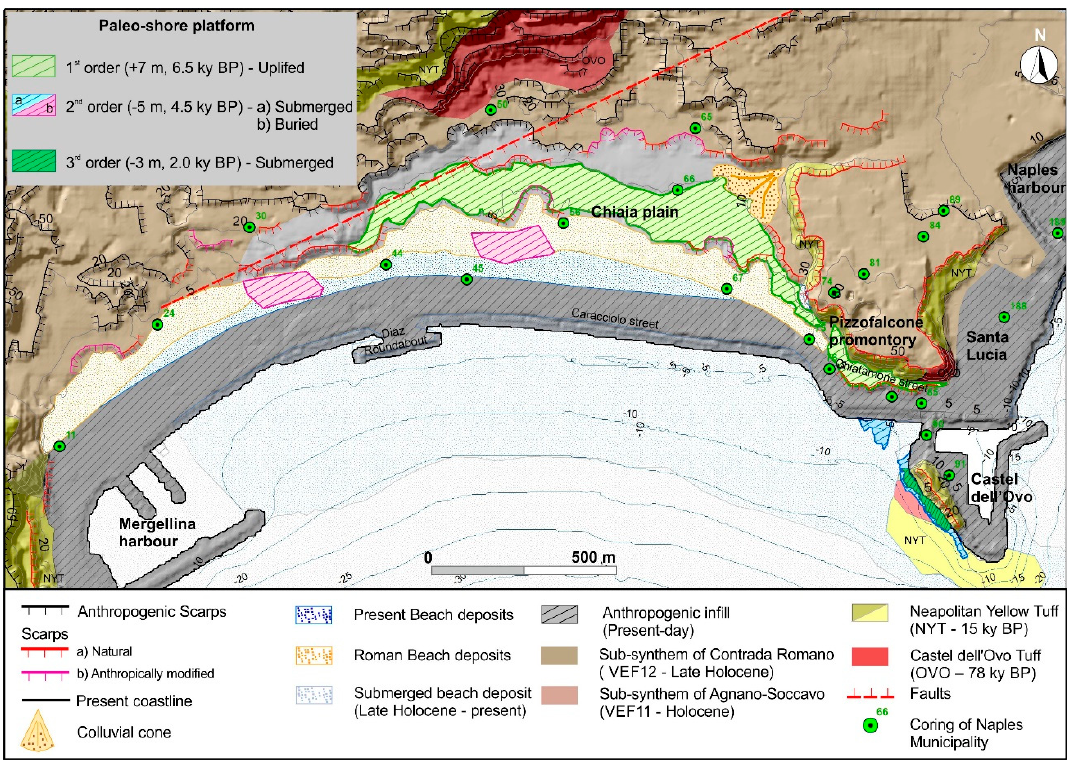
Figure 4. Geomorphological map of the study area: geological units were reconstructed by integrating data from [71] with those obtained by reinterpreting several stratigraphic records contained in the 1967 Geological Report of Naples Municipality (numbered in green in the map), and measurements taken during direct inspections carried out in the whole coastal sector.